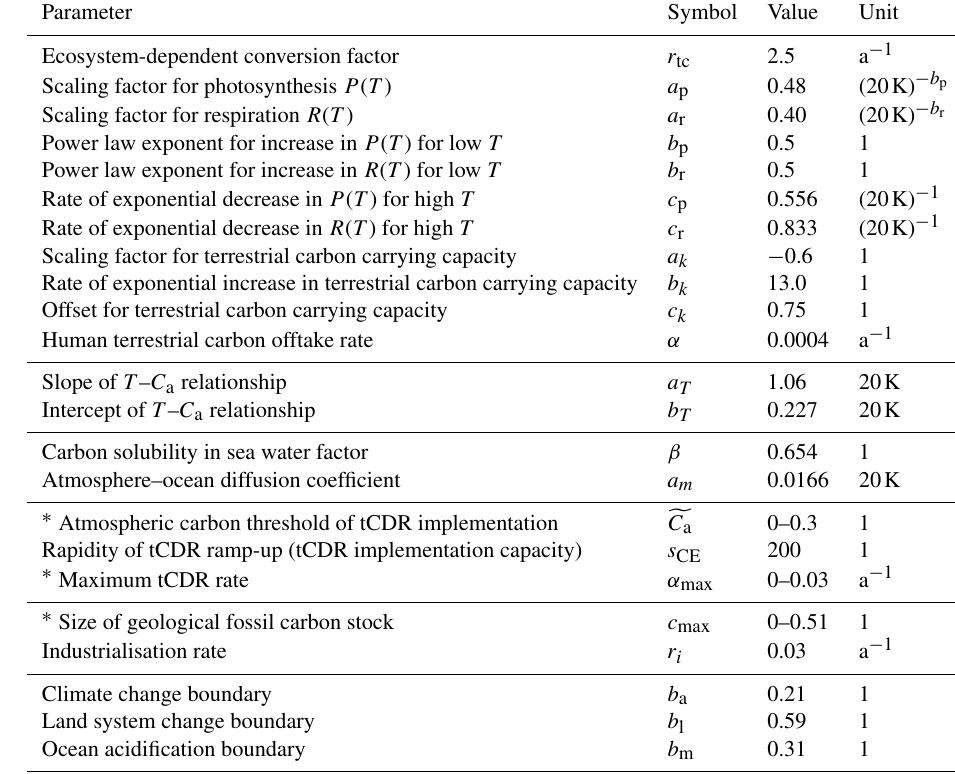
Table 2. Calibrated model parameters after normalisation to pre-industrial carbon pools. Remaining units are years (a) and temperature